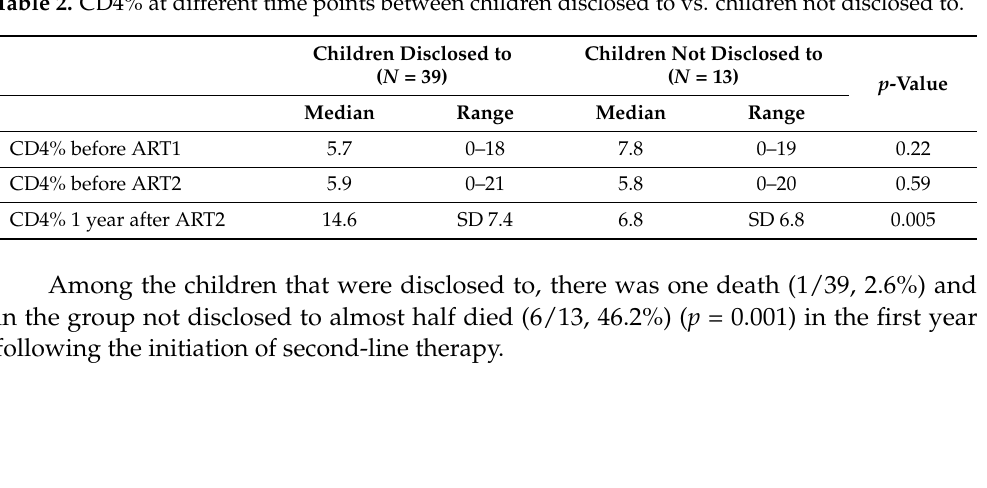
Table 2. CD4% at different time points between children disclosed to vs. children not disclosed